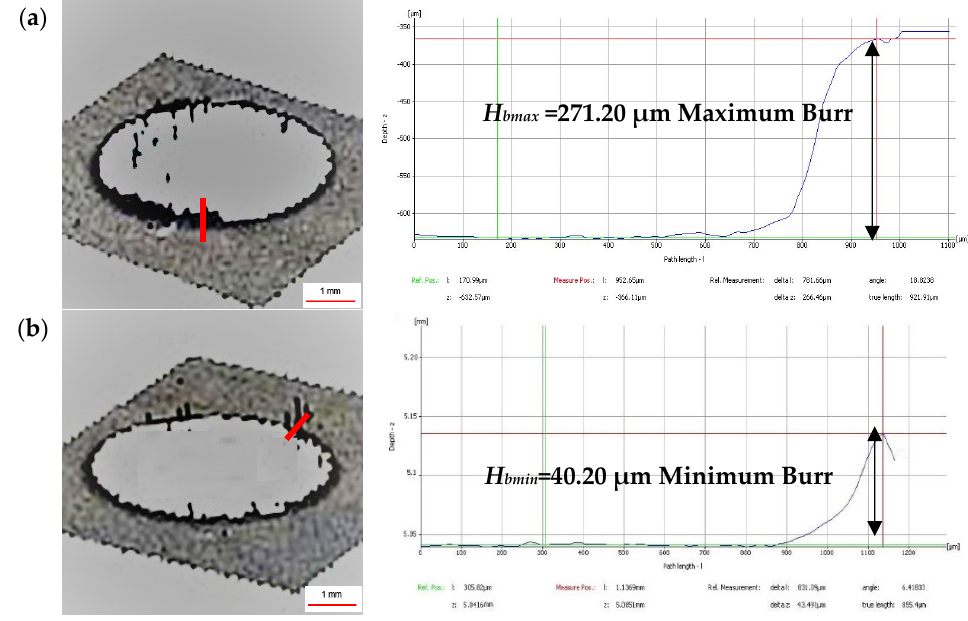
Figure 12. ( a ) Maximum and ( b ) minimum burr formation measurements.